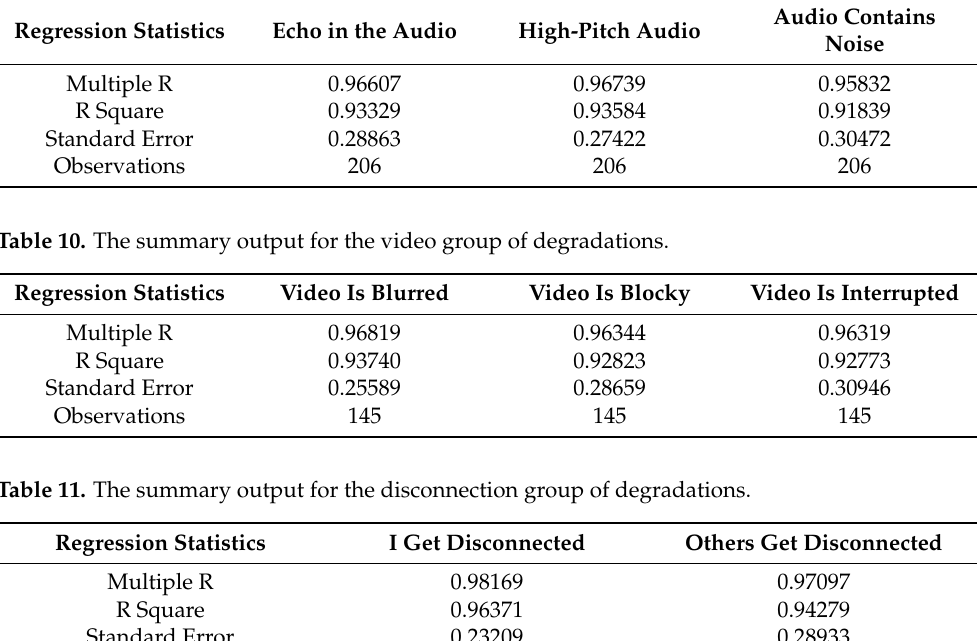
Table 9. The summary output for the audio group of degradations.